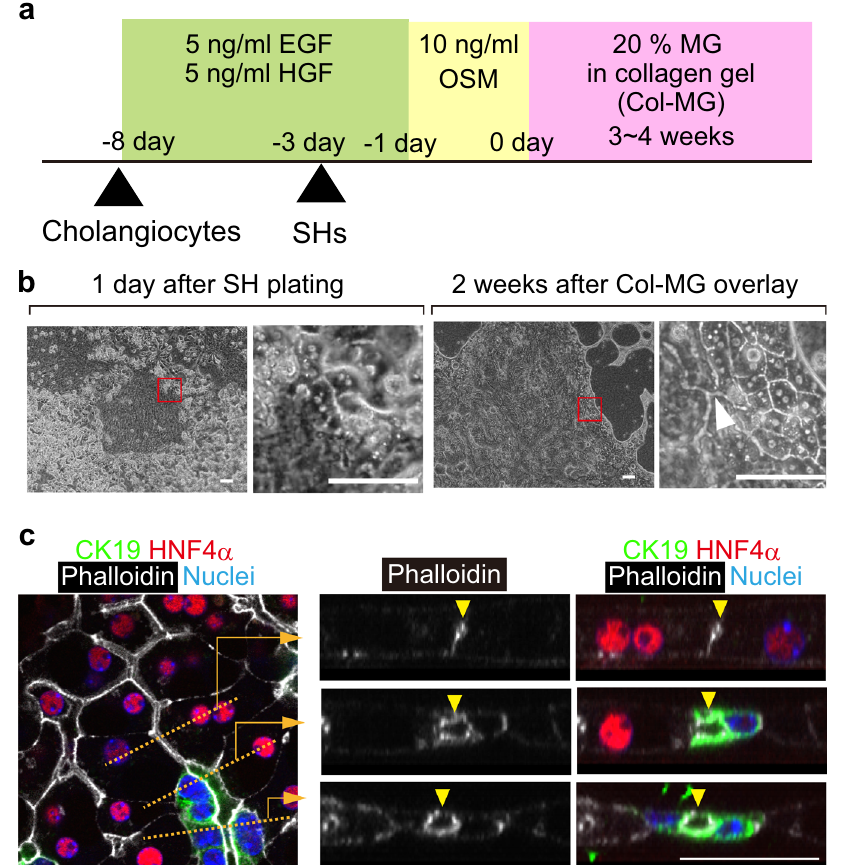
Fig. 1 Induction of hepatobiliary connections in co-cultures of SHs and cholangiocytes. a Schedule of co-culture of SHs and cholangiocytes. b Morphological changes in hepatocytes and cholangiocytes in co-culture. Cholangiocytes are in close contact with hepatocytes one day after plating SHs. At two weeks after the overlay of collagen-containing 20% Matrigel (Col-MG), the BC network of hepatocytes connects to the biliary network (an arrowhead). Co-culture was repeated more than fi fty times. The contacts and connections between hepatocytes and cholangiocytes were always observed at similar time points. Boxes are enlarged in square panels. Bars represent 100 μ m. c Hepatobiliary connections in co-culture Optical cross-sections along broken lines in the left panel are shown in the right panels. The BC within the HNF4 α + hepatocyte clusters (arrowheads in upper right panels) connect to the lumen, which consists of CK19 + cholangiocytes and HNF4 α + hepatocytes (arrowheads in middle right panels), and then eventually reach the duct of CK19 + cholangiocytes (arrowheads in lower right panels). At four weeks after MG overlay, the immunostaining with phalloidin (white), anti-HNF4 α antibody (red), anti-CK19 antibody (green), and Hoechst 33342 (blue) was repeated fi ve times independently. Three fi elds were examined in each sample. Three out of fi fteen areas were further used to collect serial optical sections for 3D reconstruction. The representative images are shown in this fi gure. Bars represent 50 μ